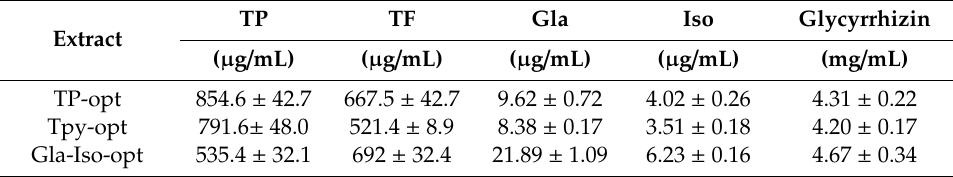
Table 6. Chemical composition of the optimized